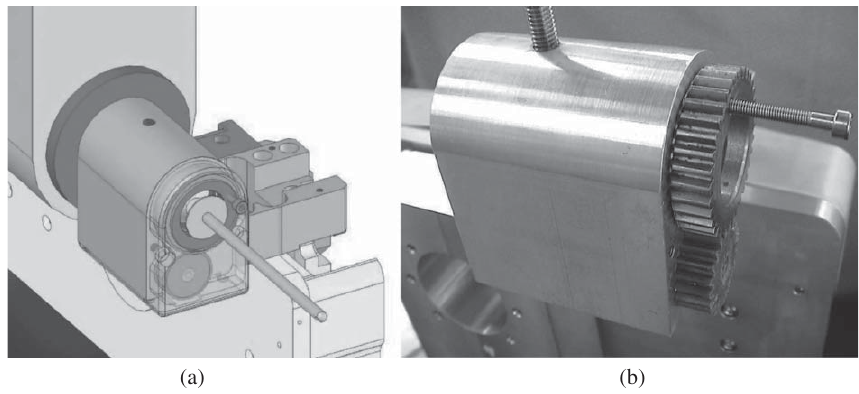
Fig. 11. Cap’s actuator. a) Actuator layout. (b Conformal cap’s